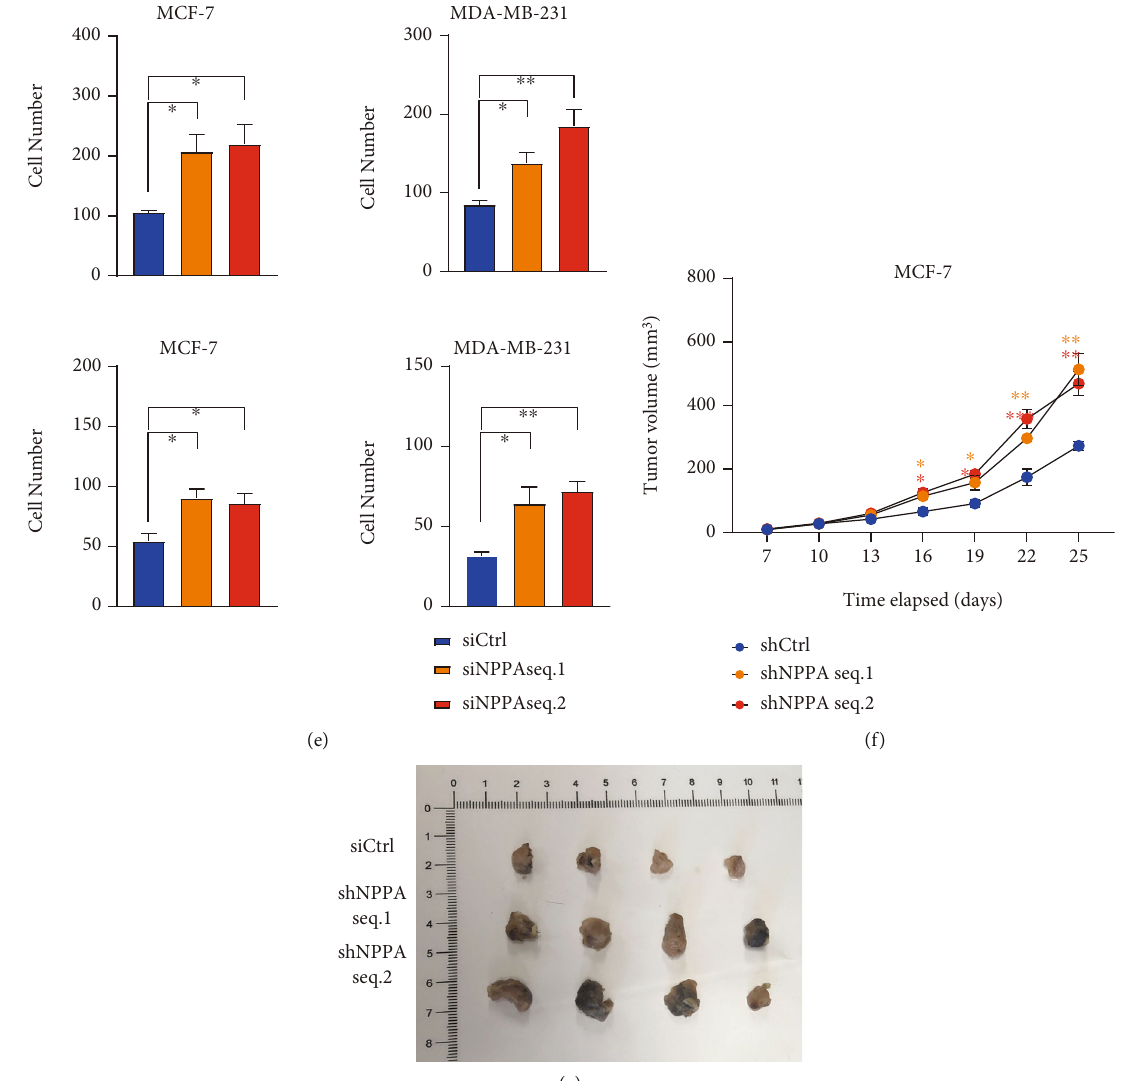
Figure 4: NPPA silencing promotes the malignant behavior of breast cancer cells. (a) Heatmap showing the proliferation potential of breast cancer patients in the TCGA database. The top three clusters of patients were identi fi ed as the high, medium, and low proliferation groups. (b) Quanti fi cation of NPPA mRNA level in the high, medium, and low proliferation breast cancer patients. (c) The proliferation curve of NPPA depleted or control cells. Experiments were performed in 4 di ff erent breast cancer cell lines. (d, e) The typical fi gure (d) and the quanti fi cation (e) of MCF-7 cells and MDA-MB-231 cells in the Transwell experiments. Migration (A) and invasion (B) were assessed, respectively, in NPPA depleted or control cells. (f, g) The proliferation curve (f) and the tumor image (g) of MCF-7 nude mouse xenograft. Tumor growth and tumor volume were assessed in NPPA depleted or control MCF-7 cells. Data are represented as mean ± SEM , ∗ p < 0 : 05 , ∗∗ p < 0 : 01 , and ∗∗∗ p < 0 : 001 . The data were analyzed using Student ’ s t observed a weak correlation of NPPA with stemness score (Suppl. Figure 3D), relative telomere length (Suppl. Figure 3E), and various T cells (Suppl. Figure 3F) in breast cancer patients. Breast Cancer Cells. Breast cancer patients were further divided into three di ff erent groups according to their sepa- rate proliferation potential (Figure 4(a)), and the expression level of NPPA was gradually decreased in patients with higher proliferation potential (Figure 4(b)).